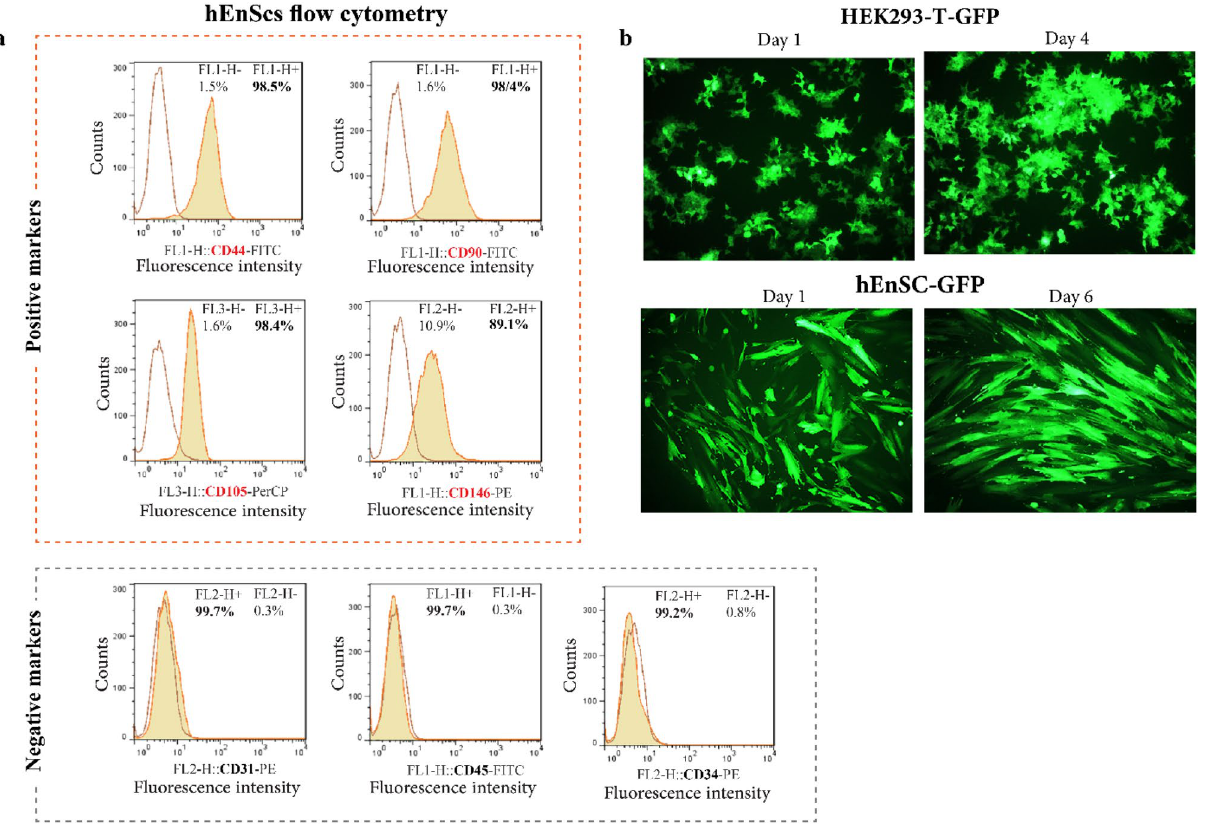
Figure 2. Characterization of cell markers for hEnSCs and verification of GFP-labeling. ( a ) The results of flow cytometric assessment of hEnSCs at passage three, isolated from the endometrial biopsy. Dark red lines display isotype control (negative control). hEnSCs were positive for mesenchymal stem cell markers CD44 (98.5%), CD90 (98.4%), and CD105 (98.4%), endometrial stem cell marker CD146 (89.1%), shown as a right shift of the fluorescent intensity peak. hEnSCs were also negative for hematopoietic CD45, CD34, and endothelial CD31 markers (no shift of the fluorescent peak was observed). ( b ) HEK293-T and hEnSCs transduction with GFP- expressing lentiviral vectors. To confirm GFP expression, the labeled HEK293-T and hEnSCs were monitored with a fluorescent